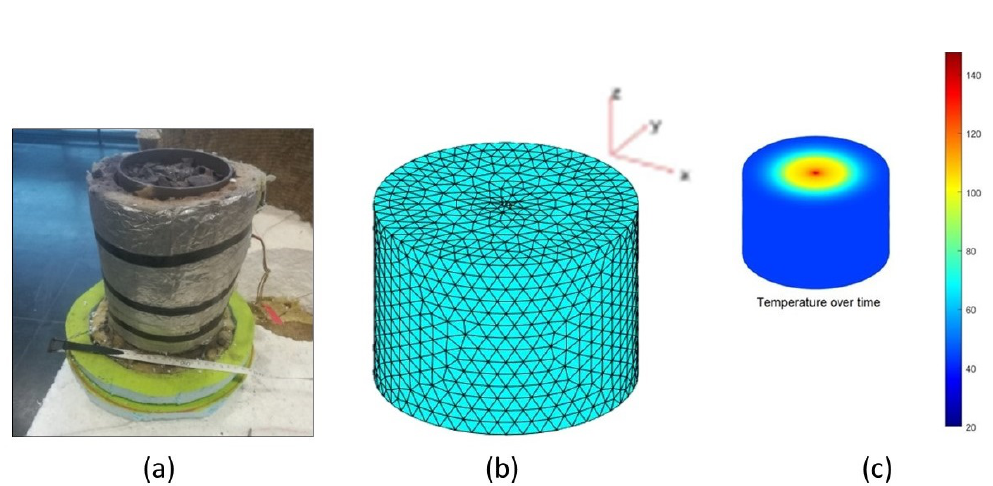
Figure 8. Reservoir overview: ( a ) experimental reservoir filled with the hematite ore; ( b ) theoretical model developed in Matlab with the inversion points; ( c ) temperature distribution in the reservoir over